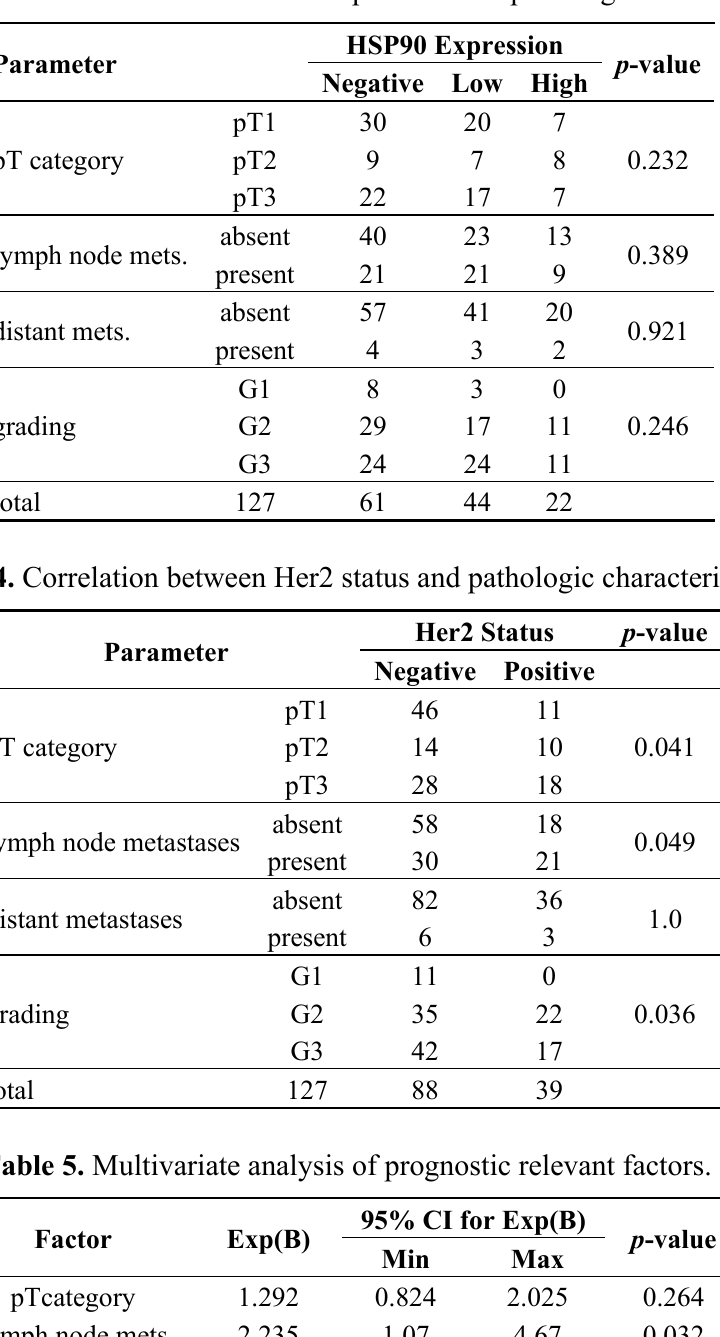
Table 3. Correlation between HSP90 expression and pathologic characteristics.